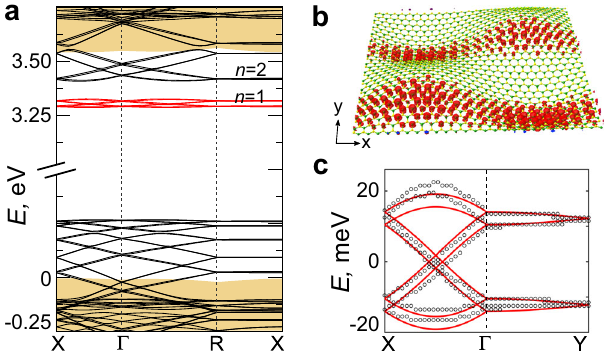
Fig. 2 Electronic structure of modulated hBN. a Calculated electronic band structure of sinusoidally deformed hBN, A = 0.079. The marked red defect- like fl at bands are due to electronic con fi nement caused by deformation. n = 1, 2 correspond to the fi rst and second eigenstate of the con fi nement, respectively. The n = 1 and 2 bands are dispersive and connected along the Г -X direction, while they are fl at along the R-X direction. The splitting along the R-X direction of both n = 1, 2 states is due to interactions along the x - direction. Yellow-shaded areas mark the bands of pristine hBN with gap in between. b The band decomposed charge density corresponding to one of the fl at bands at Г point | Ψ nk | 2 shows the one-dimensional electronic nature of the bands. c An enlarged view of the fl at bands, red in (a), plotted along X- Г -Y. The solid red line is the fi t with a 8-band tight-binding